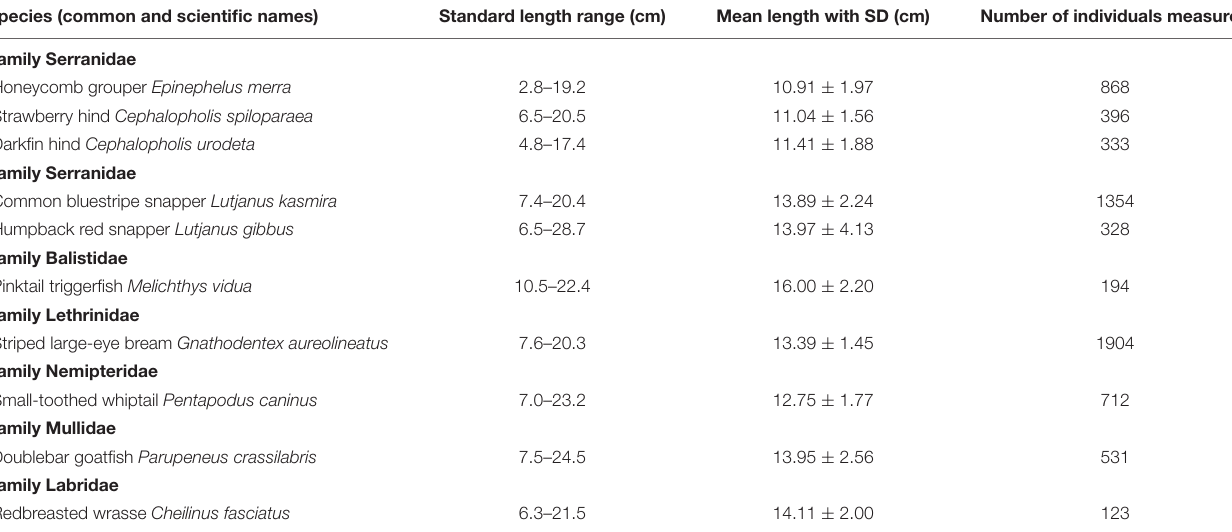
TABLE 2 | Summary of the standard length range and the sampling number of individuals of the 10 coral reef fish species collected in 2017–2019 for stock assessment in Nansha Islands, South China Sea. Species (common and scientific names) Standard length range